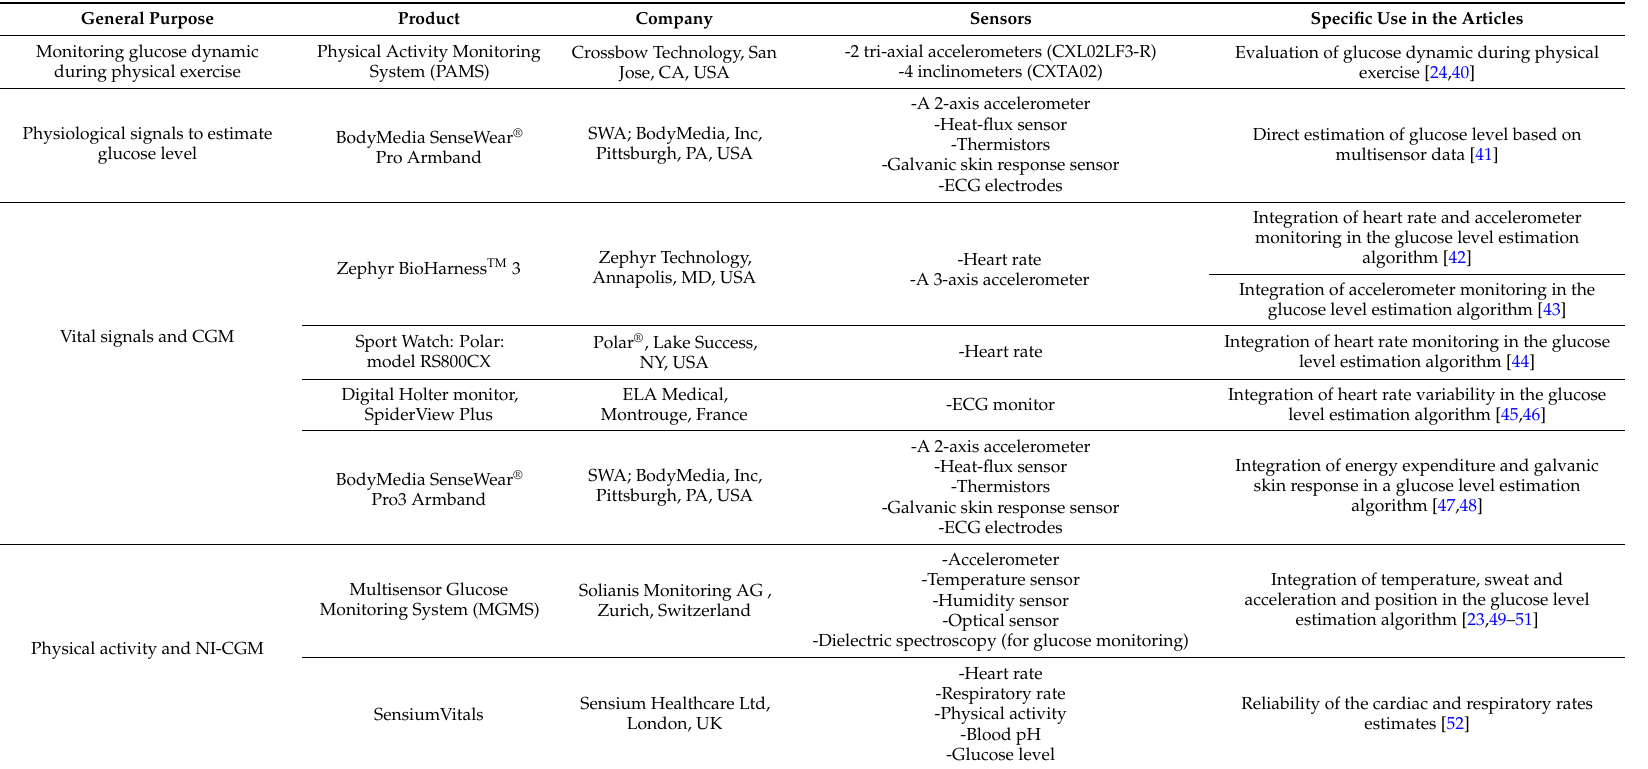
Table 1. Sensors tested in relation with physical activity in T1DM patients and their specific use in research